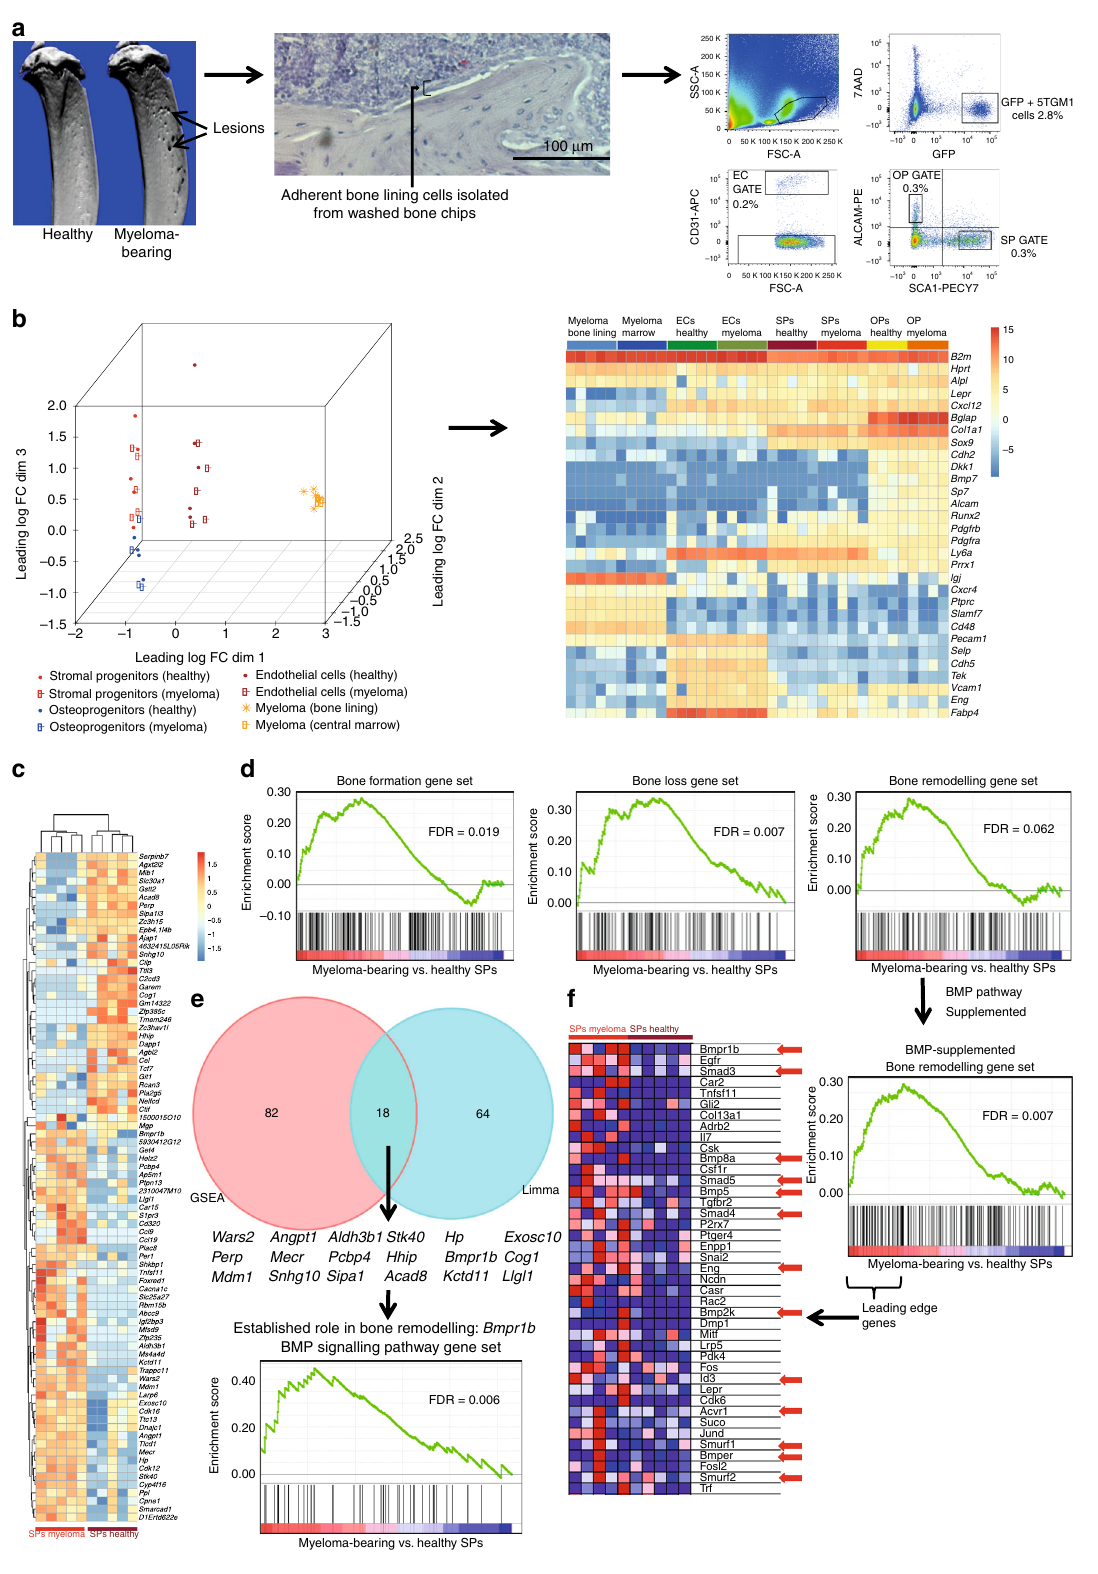
To test this, we treated 5TGM1 myeloma-bearing mice and controls with LDN193189 (LDN), a small-molecule inhibitor that functions as an antagonist of BMP type 1 receptors. LDN has been well characterised in vitro and in vivo, with high speci fi city